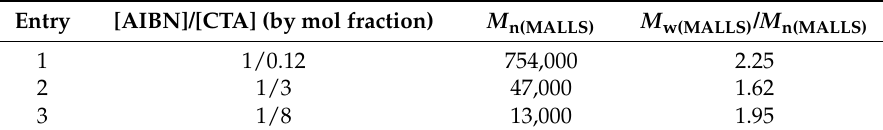
Table 1. Characteristics of poly(DEMM-TFSI) made by radical polymerization for GPC calibration curve.